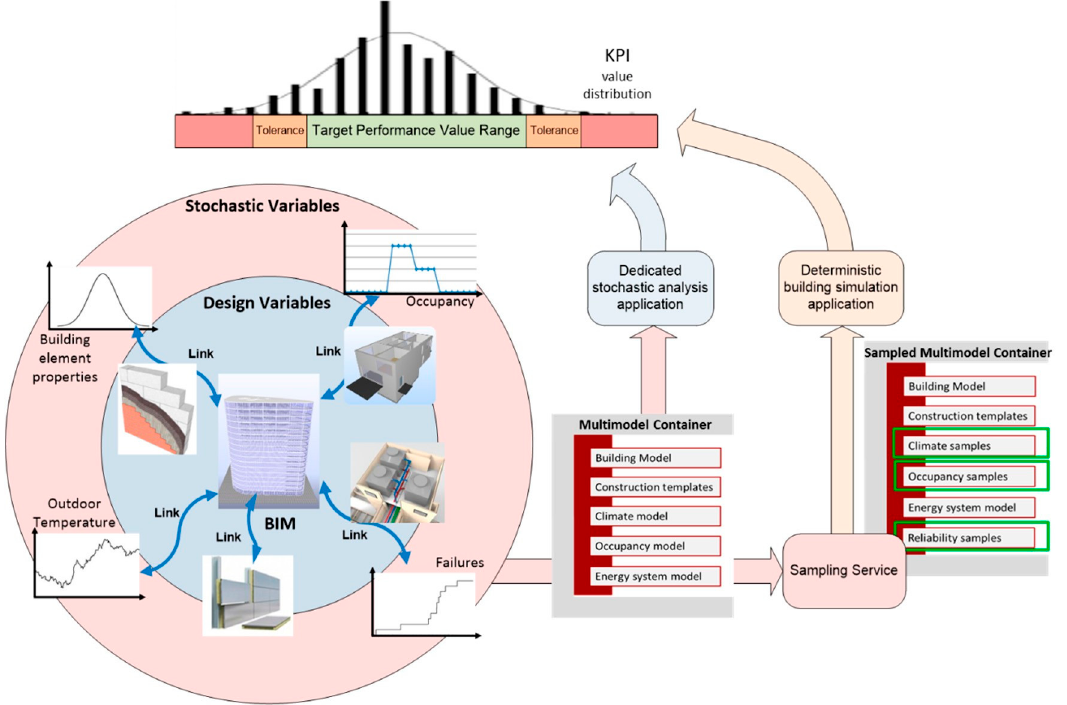
Figure 2. Illustration of aleatory uncertainty in the multimodel information space and both ways of analyzing it.